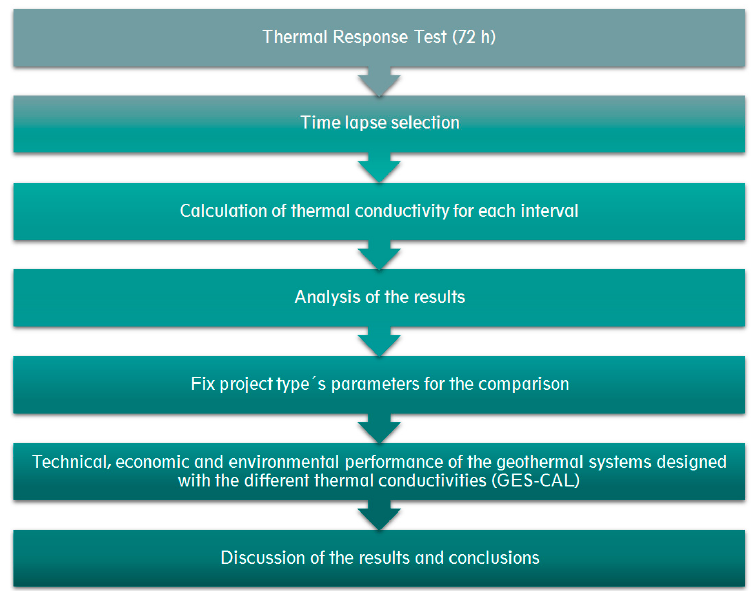
Figure 1. Workflow scheme of the present research.